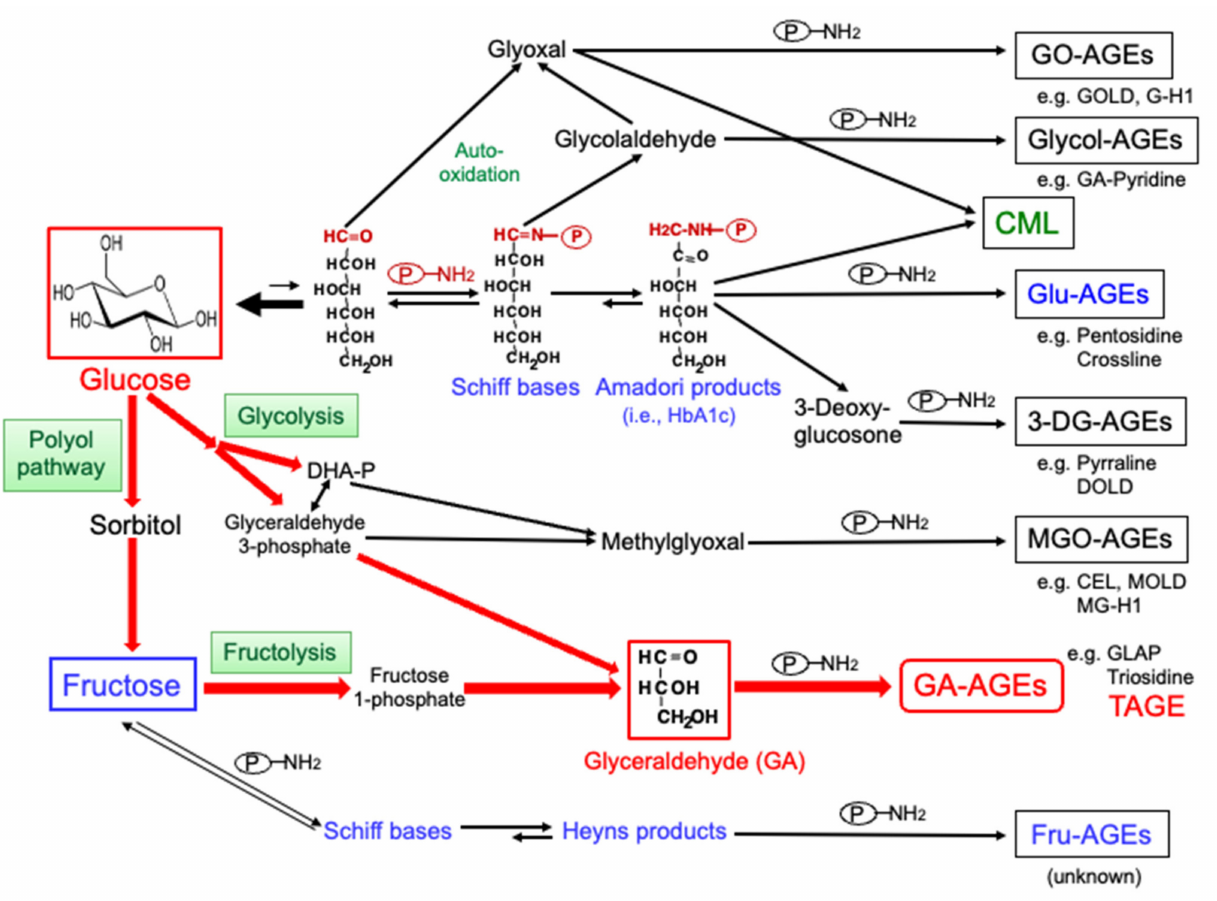
Figure 2. Routes for the production of advanced glycation end-products (AGEs) in the human body. DHA-P: dihydroxyacetone-phosphate; HbA1c: hemoglobin A1c; GO-AGEs: glyoxal (GO)- derived AGEs; Glycol-AGEs: glycolaldehyde-derived AGEs; CML: N ε -(carboxymethyl)lysine; Glu- AGEs: glucose-derived AGEs; MGO-AGEs: methylglyoxal (MGO)-derived AGEs;